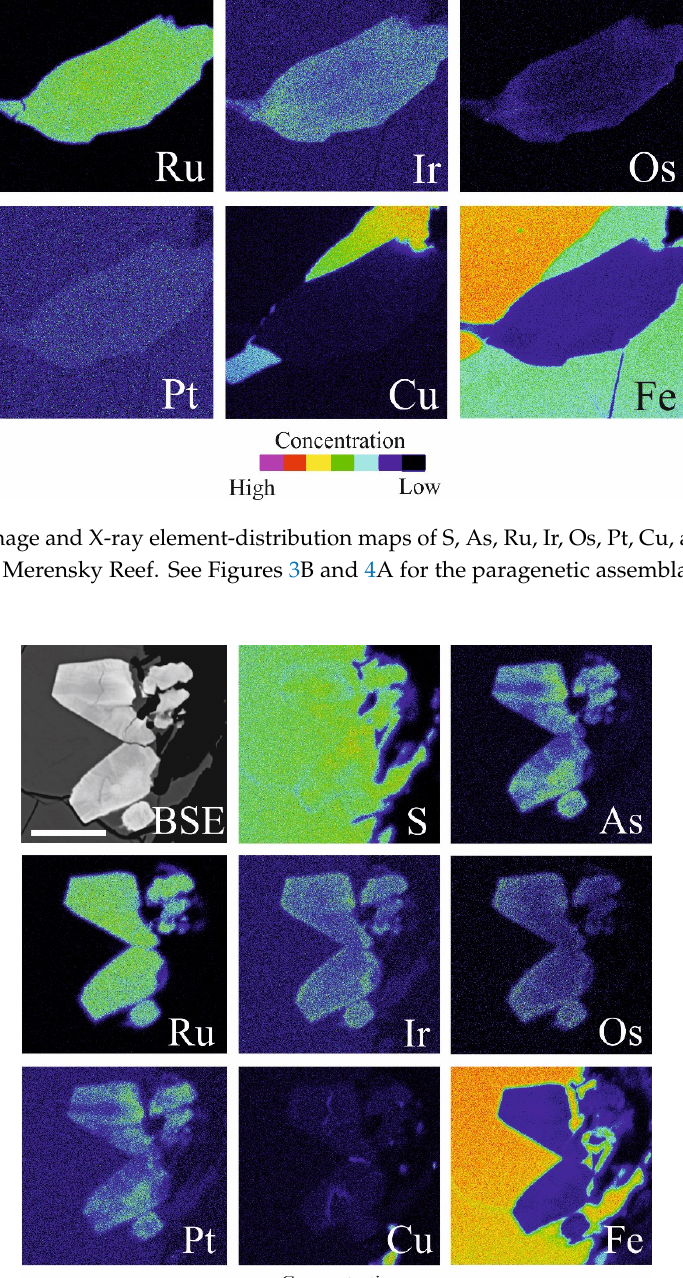
Figure 7. BSE image and X-ray element-distribution maps of S, As, Ru, Ir, Os, Pt, Cu, and Fe, showing the zoning of the laurite from the Merensky Reef, see reflected-light image of Figure 4D for the mineralogical assemblage. Scale bar is 20 µm.